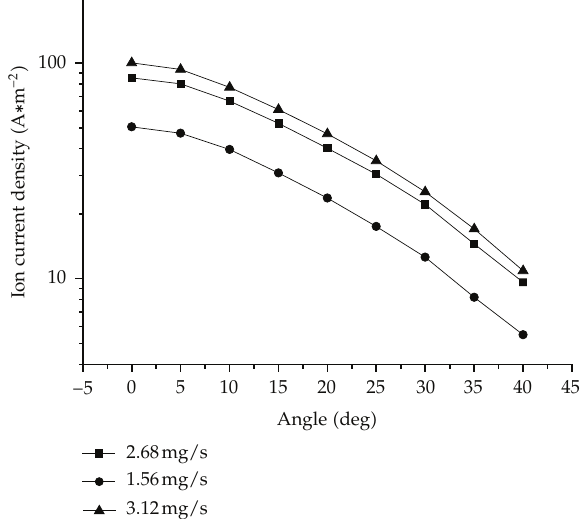
Figure 10: Current density at L (cid:9) 25cm for di ff erent mass flow